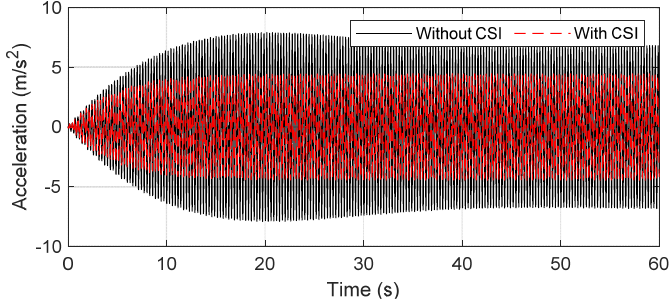
Figure 5. Comparison of structural mid—span acceleration with and without CSI effect.